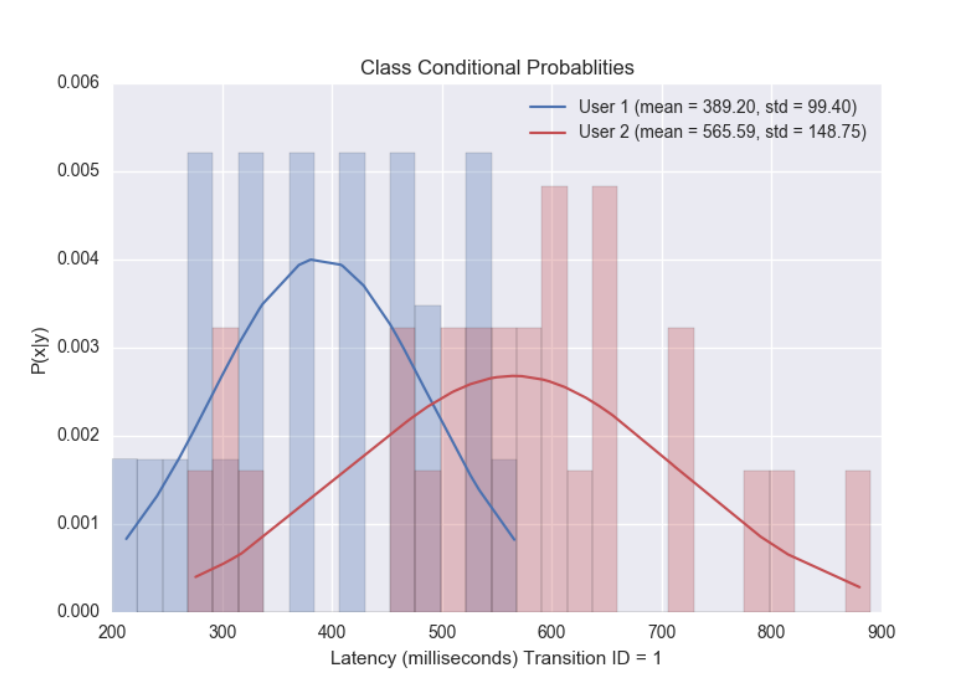
Figure 13. Class-conditioned Probability for two Users typing a specific PIN.